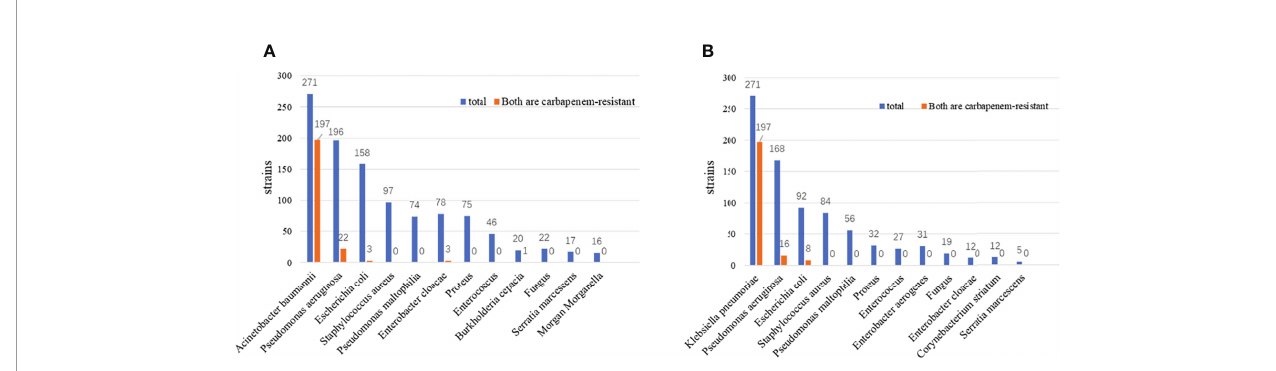
FIGURE 1 | (A) Co-isolates in polymicrobial Klebsiella pneumoniae infections; (B) Co-isolates in polymicrobial Acinetobacter baumannii